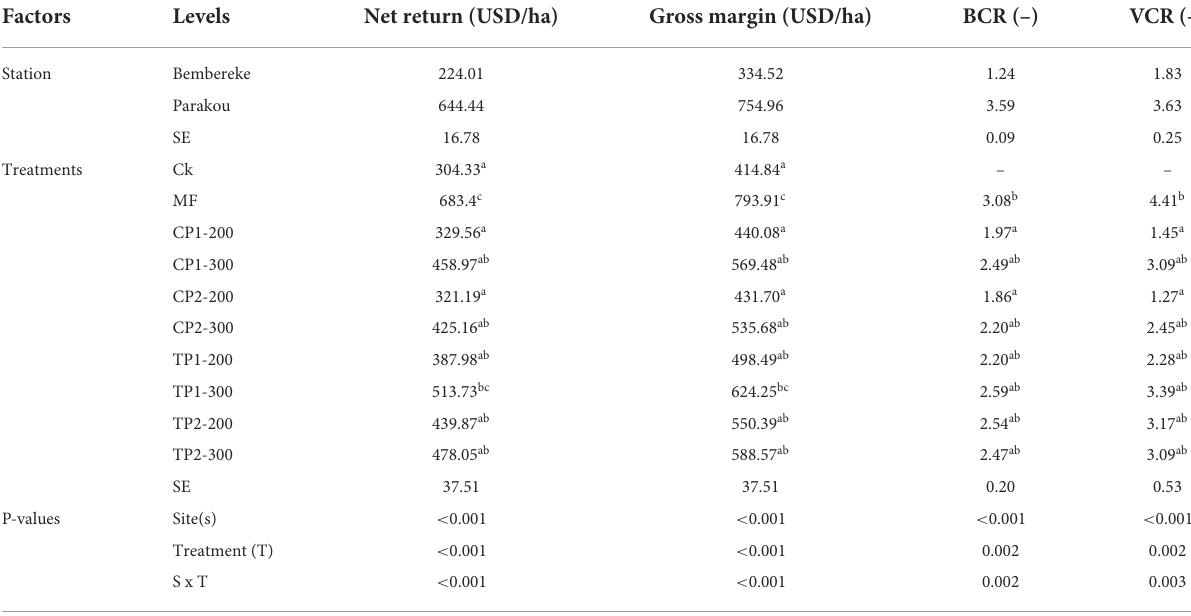
TABLE 5 Effect of different biochar-based amendments on economic indicators at the two on-station experimental sites in northern Benin.